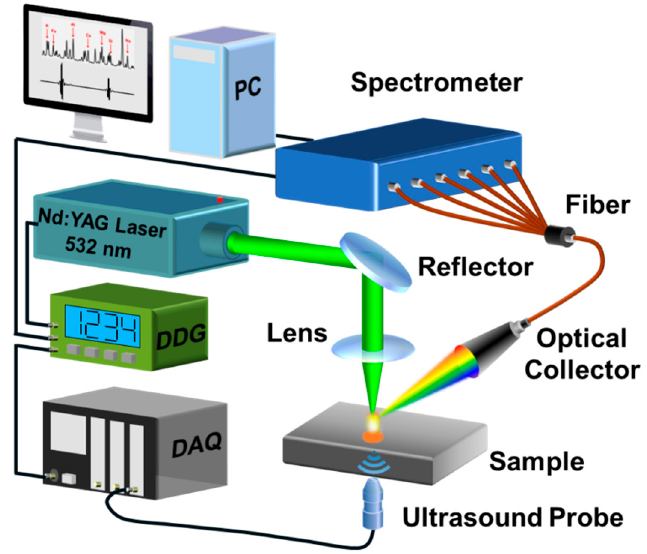
Figure 1. Schematic diagram of the experimental setup. A 532 nm Nd: YAG laser was used to ablate